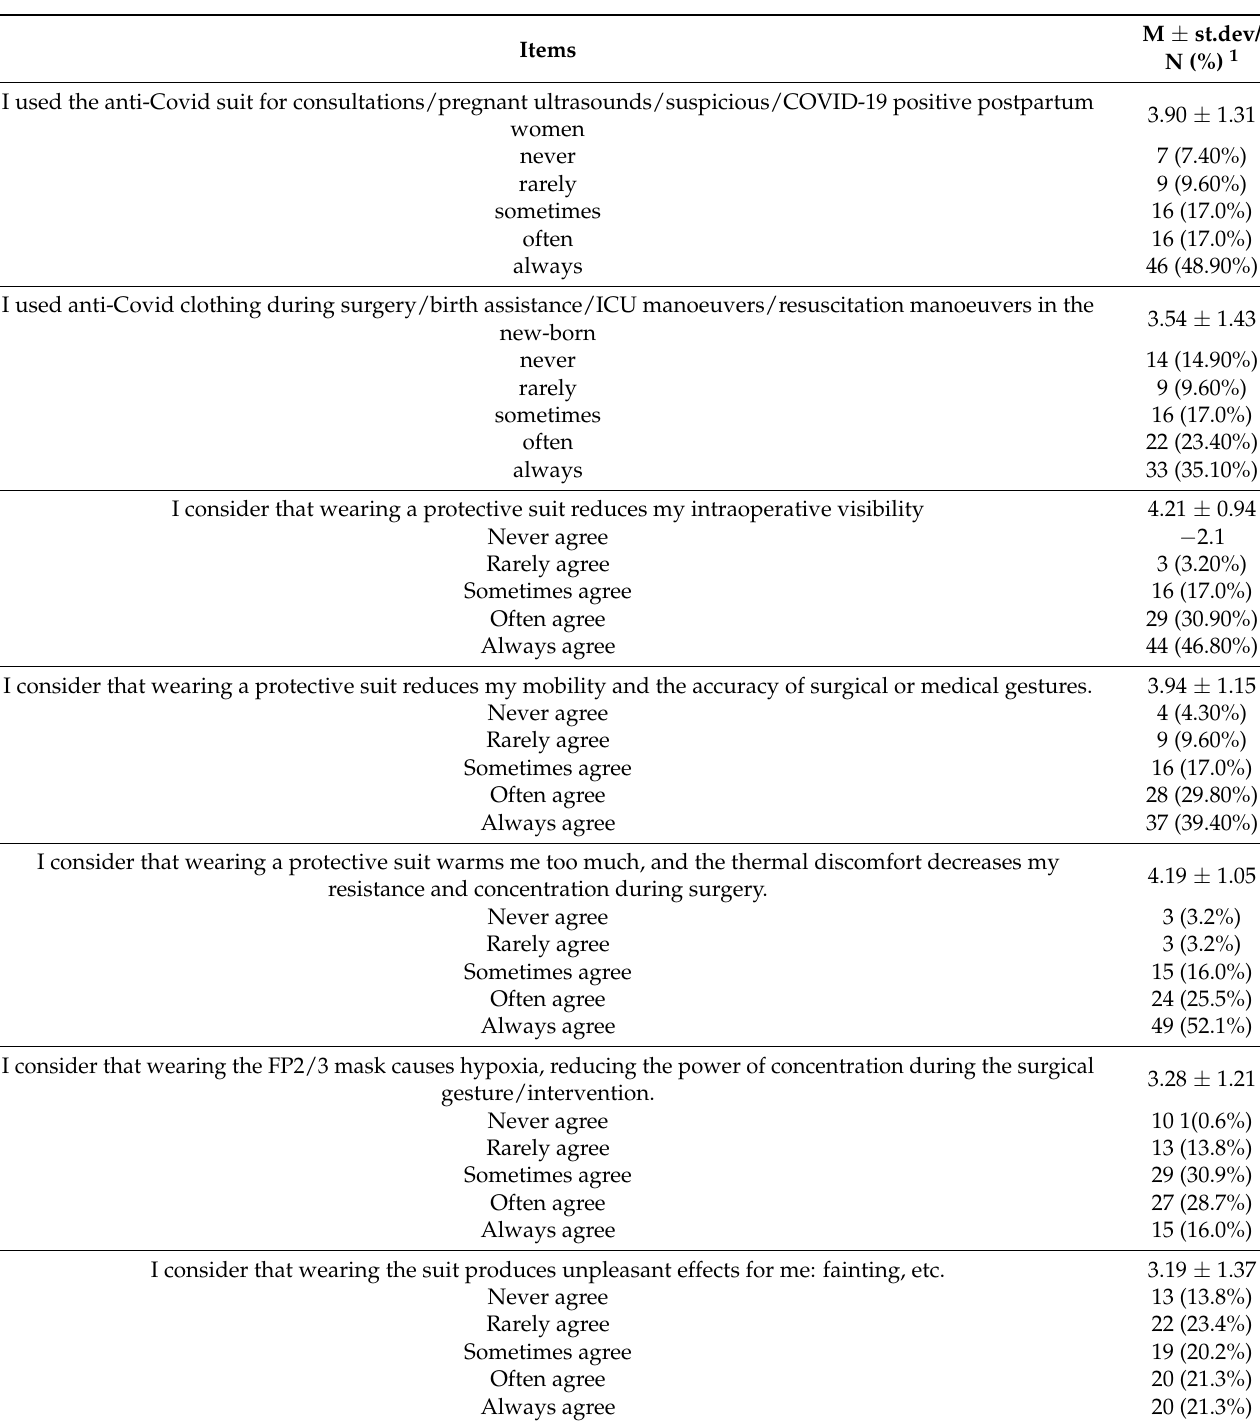
Table 5. The distribution of answers to the items investigating the protection measures against infection.